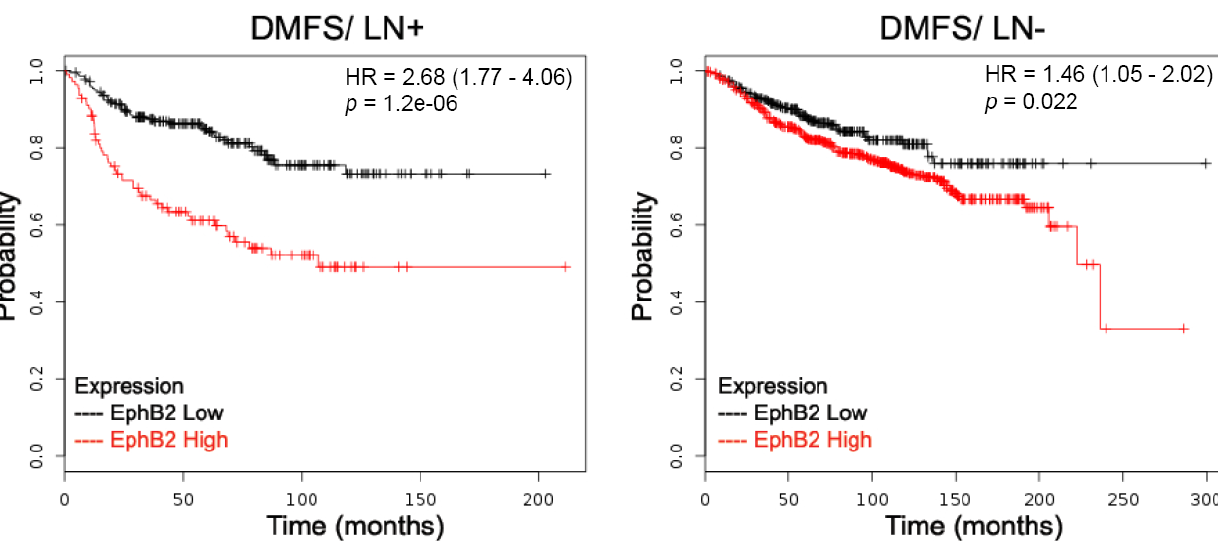
Figure 3. Prognostic value of EphB2 expression in distant metastases. EphB2 expression levels were correlated with distant metastasis-free survival (DMFS) and lymph node status. Survival of two groups of patients, with low versus high EphB2 mRNA expression levels, was compared: patients with positive lymph nodes (LN+) versus patients with negative lymph nodes (LN-). Both hazard ratios (HR) with 95% confidence intervals and log-rank p values were calculated.